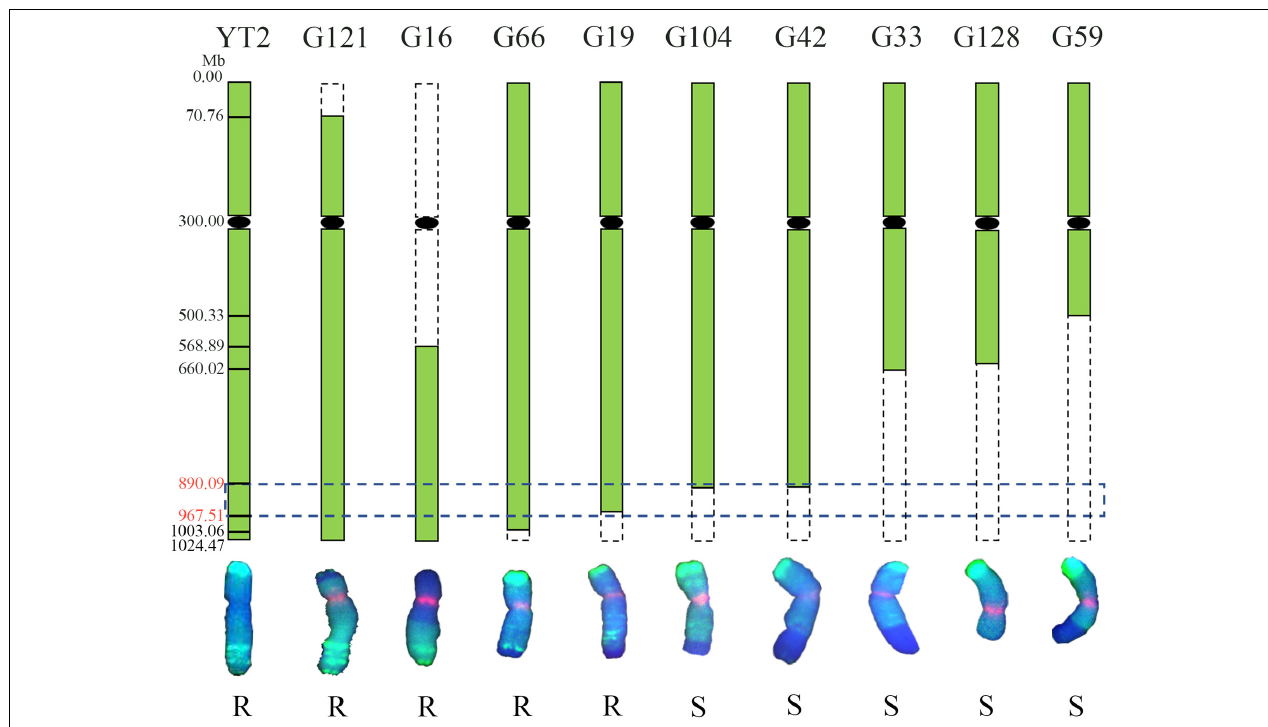
FIGURE 5 | Physical mapping of the powdery mildew resistance gene of YT2. The green boxes represent 6R chromosomes, and the horizontal dotted box indicates that the powdery mildew resistance gene of YT2 was mapped to chromosome 6RL: 890.09–967.51 Mb, corresponding to the reference genome of Weining rye. The vertical dotted boxes represent missing chromosome segments of 6R. The bottom chromosomes were captured in GISH analysis and counterstained with 4 (cid:48) ,6-diamidino-2-phenylindole (DAPI) (blue), and rye chromatin displays green signals. The letters R and S indicate the derivative lines that were resistant and susceptible to powdery mildew. TABLE 1 | Agronomic traits of YT2, and its wheat parents Shixin 616 and triticale parent 09R2-100. Year Line Plant height Spike length Spike number Fertile spikelet Thousand kernel Kernel number Grain yield (cm) (cm) per plant number per spike weight (g) per spike per plant